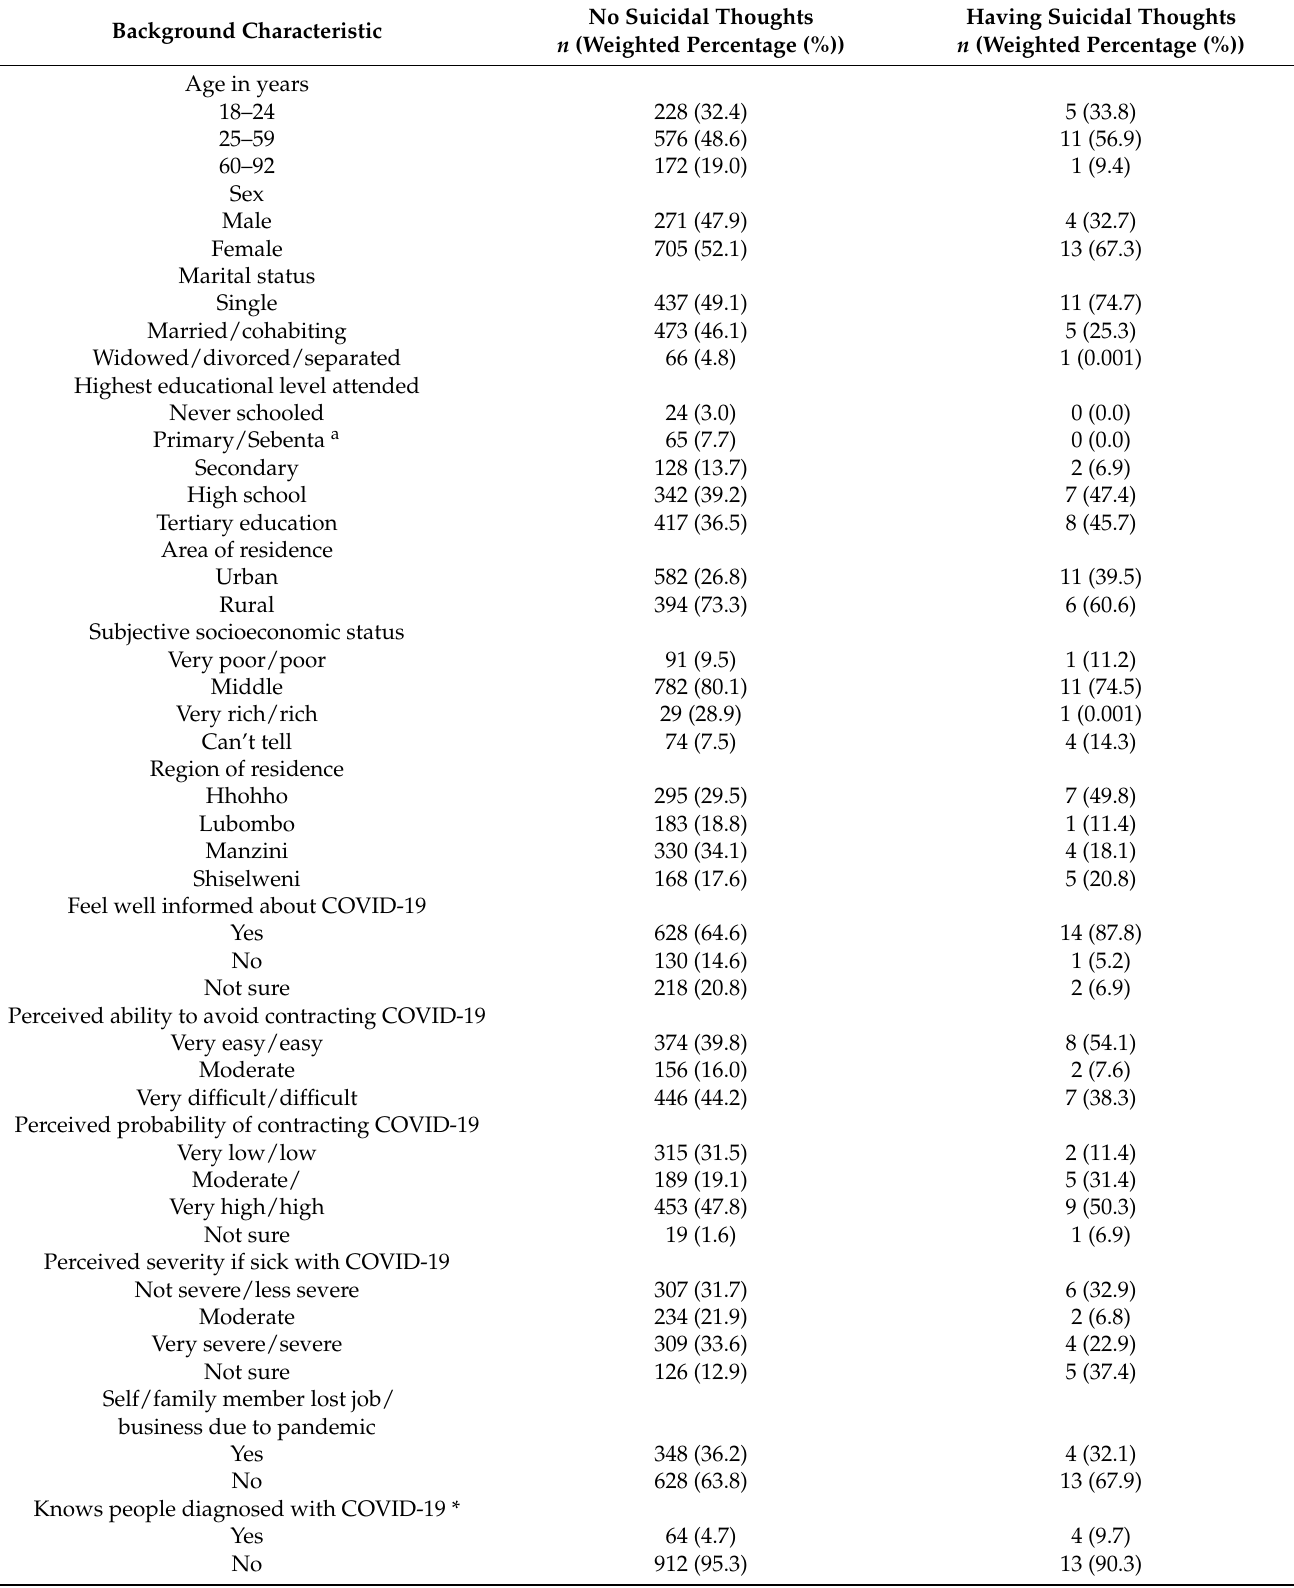
Table 2. Weighted distribution of background characteristics of the sample by suicidal ideation ( N =